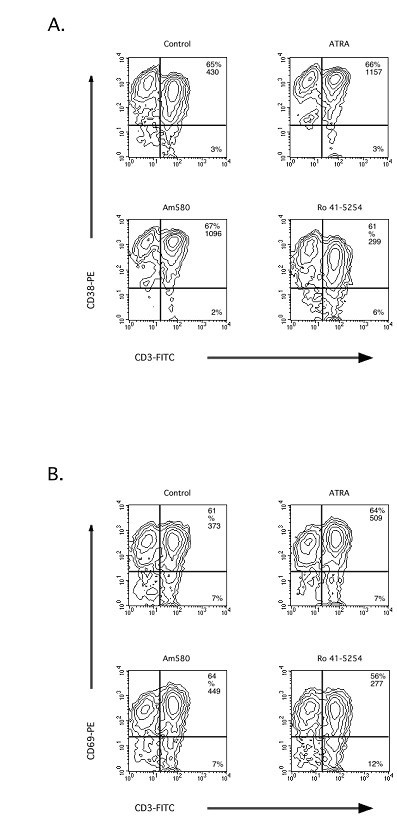
A RAR- α agonist induces and the RAR- α antagonist, R0 41–5254, reduces the expression of CD69 and CD38 on human T cells during activation. PBMC were activated with anti-CD3, mAb in the presence or absence of control ETOH or 10-7 M of ATRA, AM580, or RO41-5254 for 48 h. After activation, the cells were harvested and the cell surface levels of CD69 and CD38 were assessed by flow cytometric analysis as described in the Materials and Methods. The data are representative of all of the donors tested.